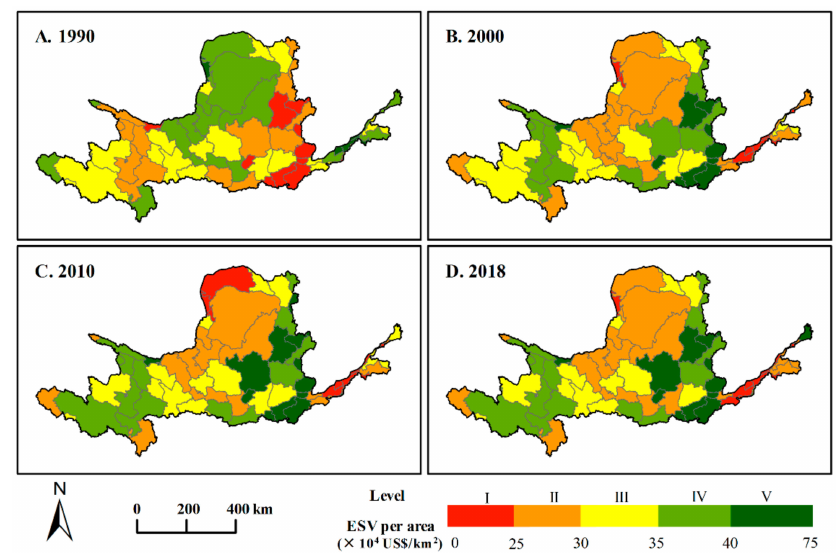
Figure 6. Spatial distribution of average ESV (AESV) in the YRB from 1990 to 2018.